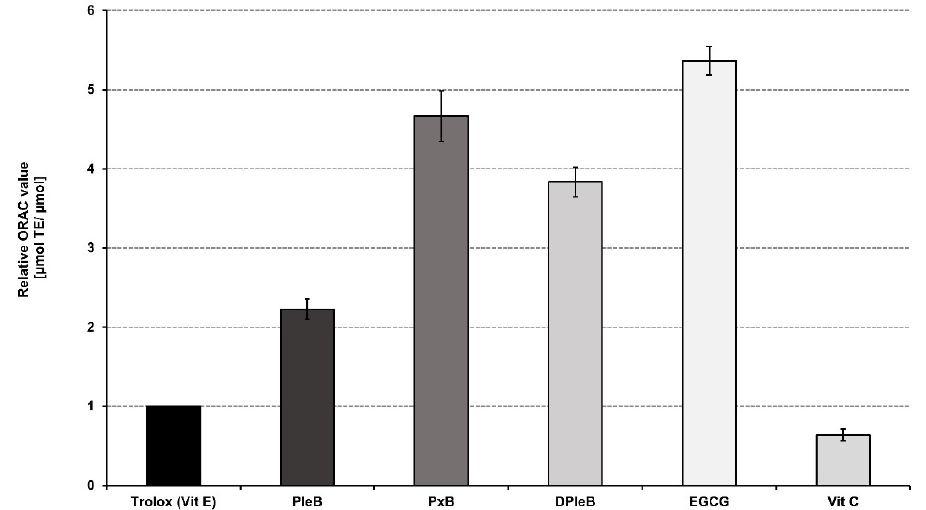
Figure 1. Oxygen radical absorbance capacity (ORAC) of phyllobilins. The capacity to inhibit peroxyl-radical-induced fluorescein oxidation was determined in an in chemico assay system, comparing the phyllobilin’s activity with the scavenging potential of Trolox (a water-soluble vitamin E). The relative ORAC value is expressed as µmol Trolox equivalent/µmol test substance. Measurements were preformed 4-times in duplicates (2-times in duplicate for vitamin C (Vit C)), values shown are mean ± standard error of the mean (SEM). EGCG: epigallocatechin-gallate.